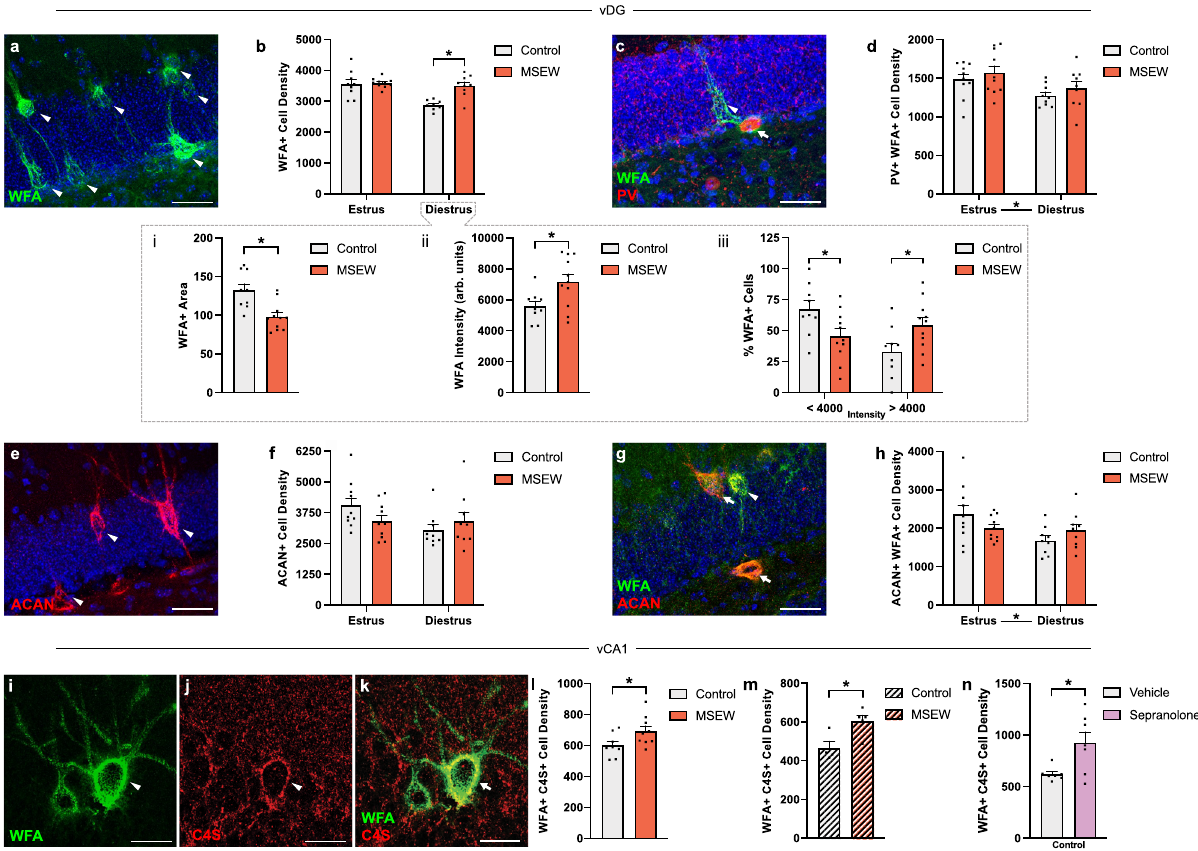
Fig. 4 | MSEW eliminates estrous cycle-mediated changes in the number of neuronswithPNNsandaltersPNNintensityandcomposition.a Confocalimage of WFA+cells in vDG. b The density of WFA+cells is higher during estrus than diestrus in controls ( F 1,32 =14.26, p =0.0007; Control-MSEW Diestrus p =0.0003), but not in MSEW mice (Control: Estrus n =9, Diestrus n =8; MSEW: Estrus n =10, Diestrus n =9). bi During diestrus, MSEW mice have smaller PNNs than